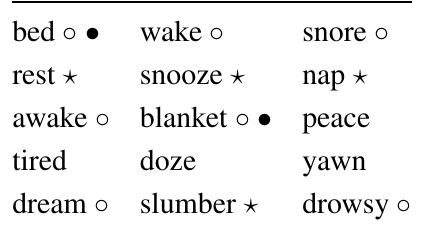
Table 14. DRM list for target sleep (outlink ◦ , inlink • , redirect/anchor (cid:63)